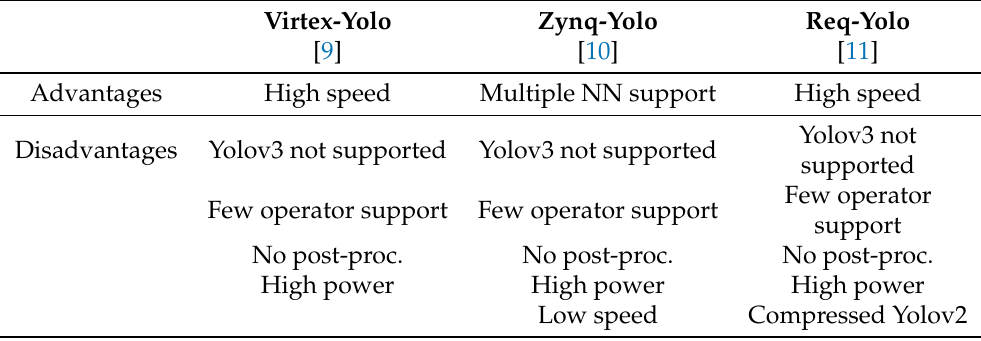
Table 1. Summary of state-of-the-art object detection using FPGA